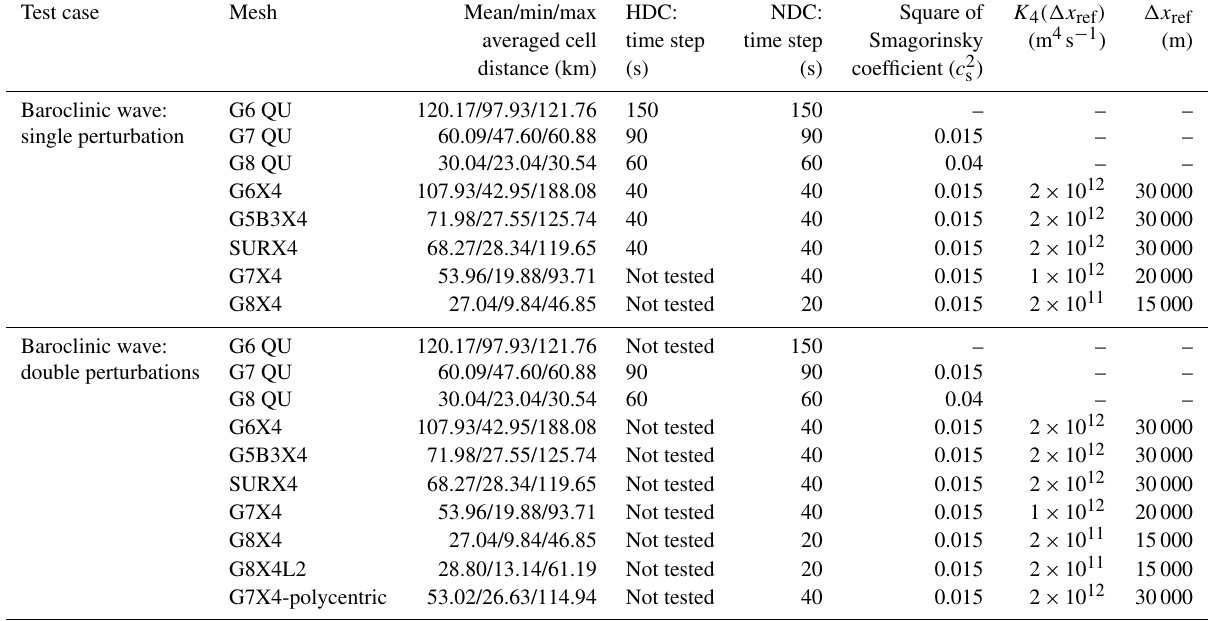
Table 1. Mesh resolution, time steps, and diffusion coefficients for the dry-atmosphere